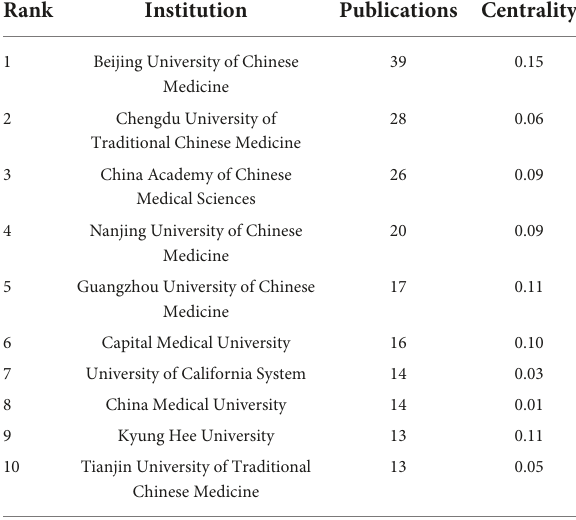
TABLE 3 The top 10 active